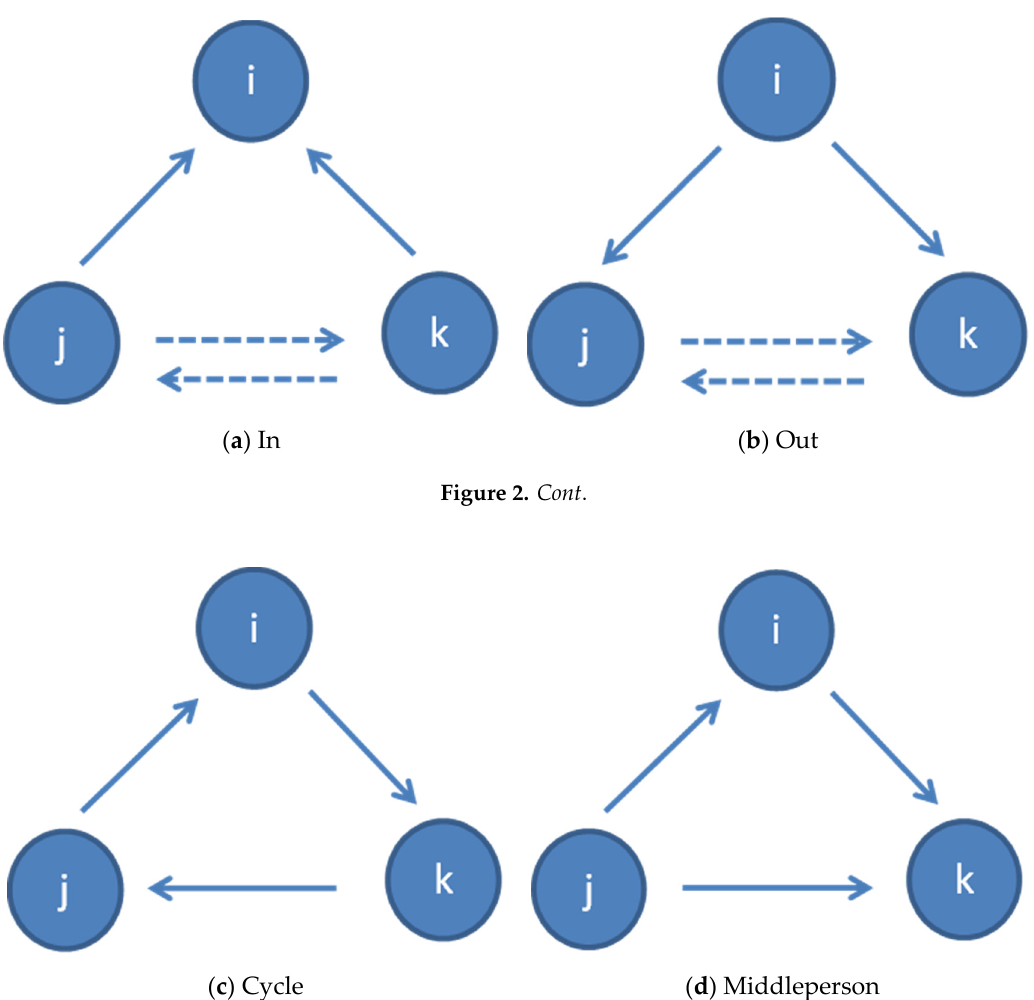
Figure 2. Possible triangles in directed clustering coefficient analysis.